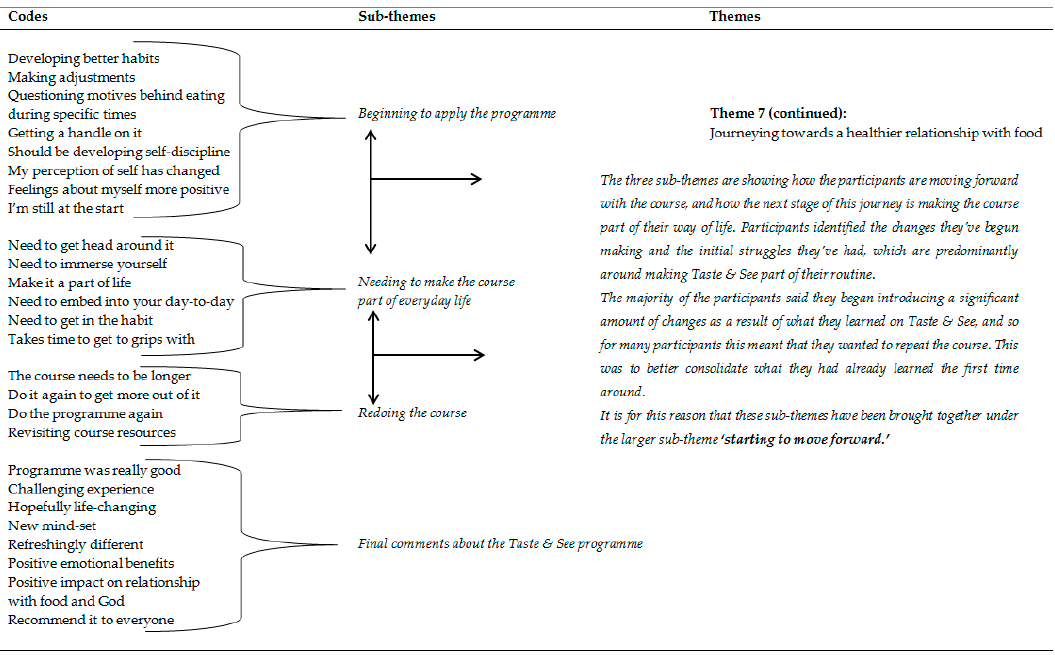
Figure 1. Thematic map of the analysis process displaying how codes were translated into themes.